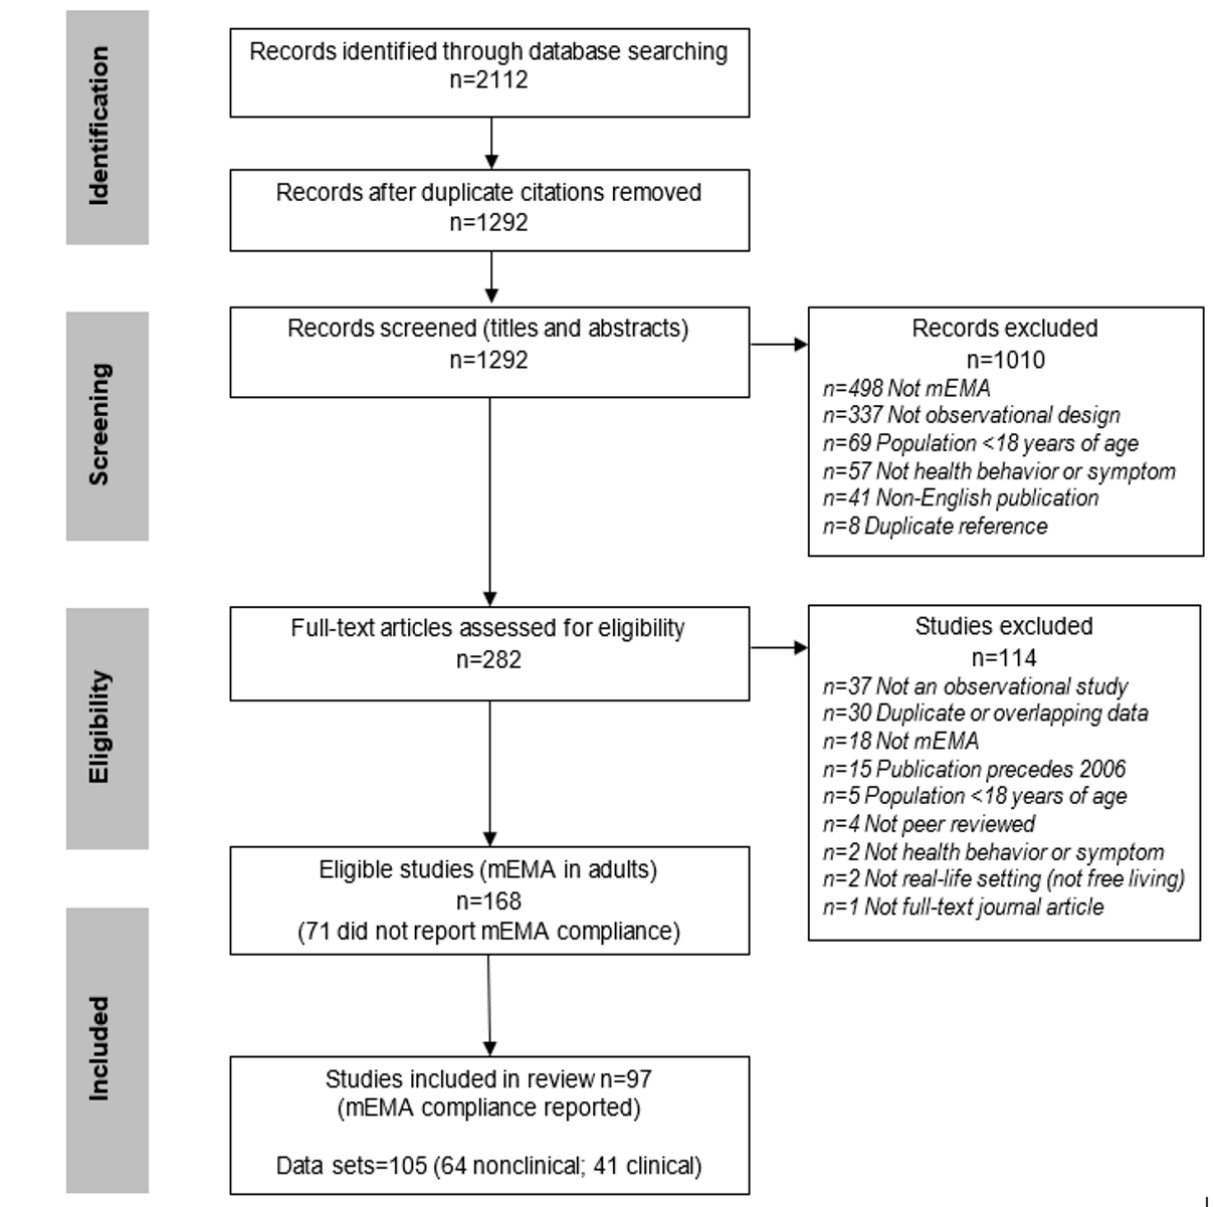
Figure 1. Search strategy process and final outcomes (hand searching of reference list-eligible studies and review papers did not identify additional studies to those returned by database searches). mEMA: mobile ecological momentary